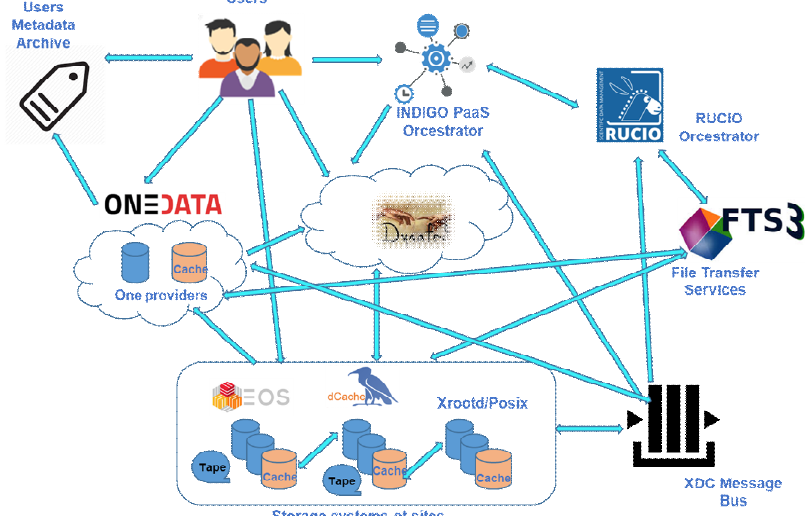
Figure 1 - The XDC high-level architecture and relationships among